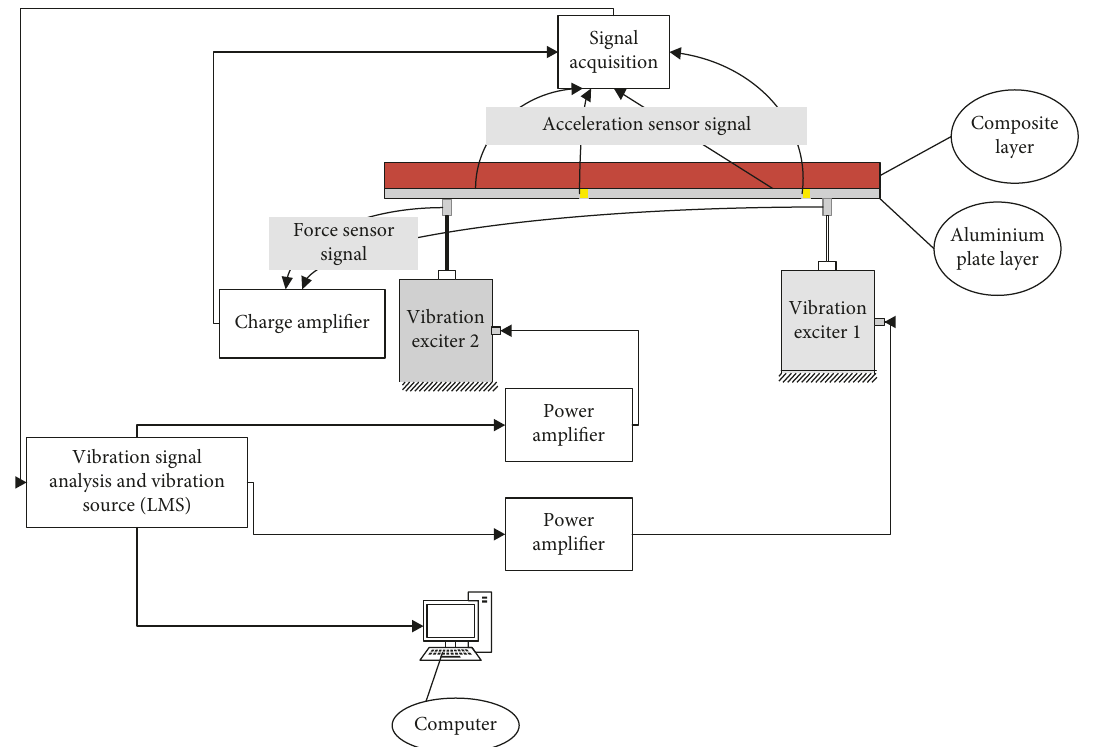
Figure 7: Connection of vibration exciter, force sensor, and composite plate.